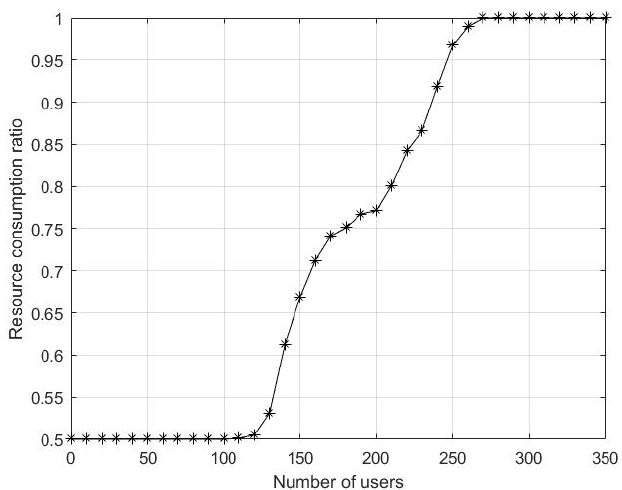
Figure 15. Resource occupancy of dynamic Walsh code slot random access protocol.